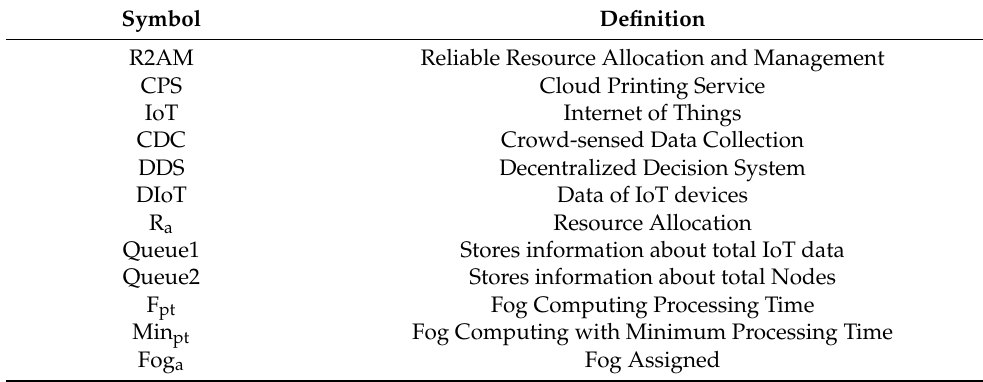
Table 2. List of abbreviations and used